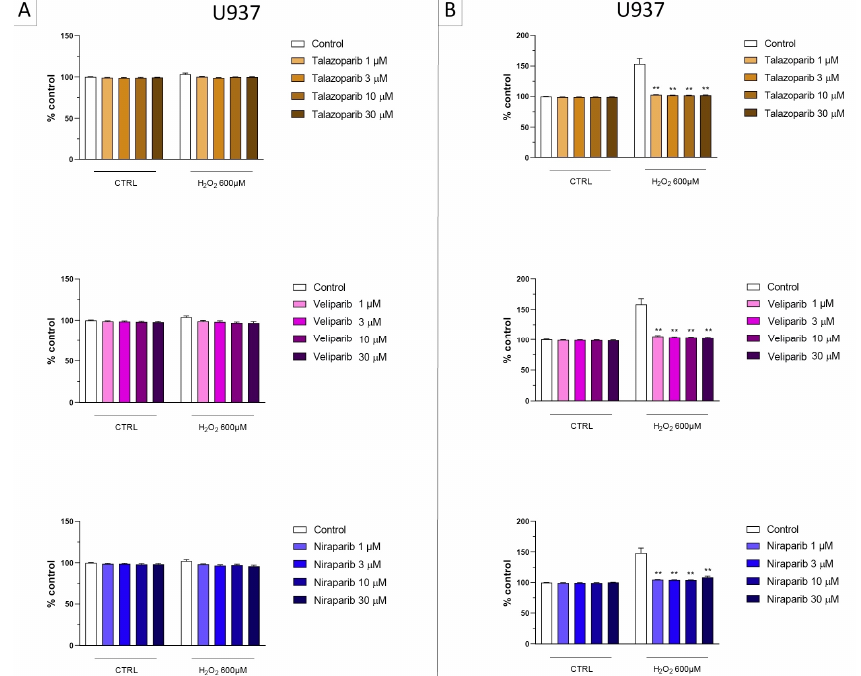
Figure 5. Effect of the clinical-stage PARP inhibitors talazoparib, veliparib, or niraparib on H 2 O 2 - induced cell necrosis in U937 cells. Cells were treated for 2 h ( A ) or 24 h ( B ) with 600 µM H 2 O 2 ; the PARP inhibitors were applied at different concentrations (1, 3, 10, and 30 µM). Cell necrosis was measured by measurement of LDH levels in the supernatant. ** p < 0.01 indicates the beneficial effect of PARP inhibition to counteract the effect of oxidative stress. Data are shown as mean ± SEM of n = 5 independent